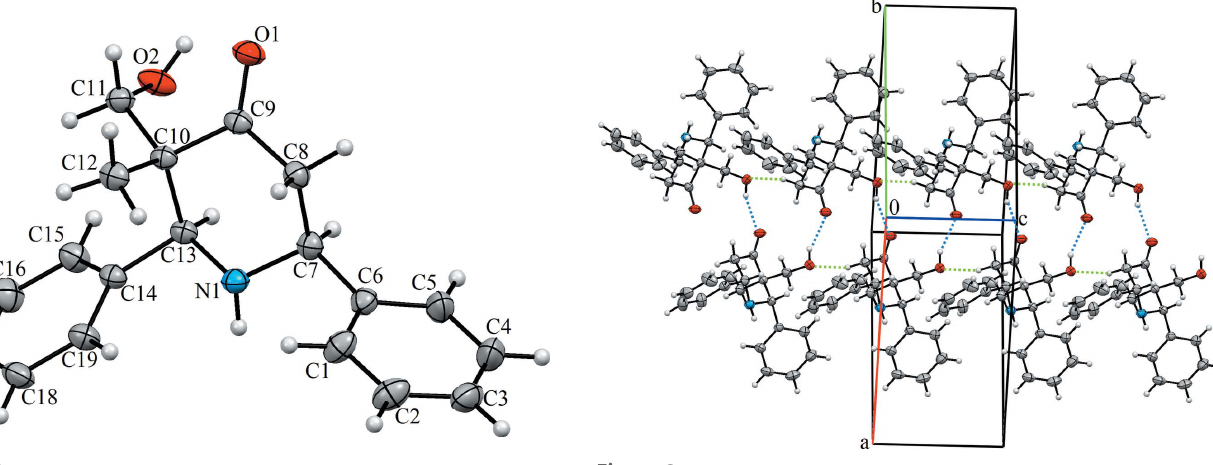
Figure 2 View of the hydrogen-bonded double ribbon in the title structure showing C8—H8 A (cid:3)(cid:3)(cid:3) O2 hydrogen bonds as green dashed lines and O2— H2 (cid:3)(cid:3)(cid:3) O1 hydrogen bonds as blue dashed lines.